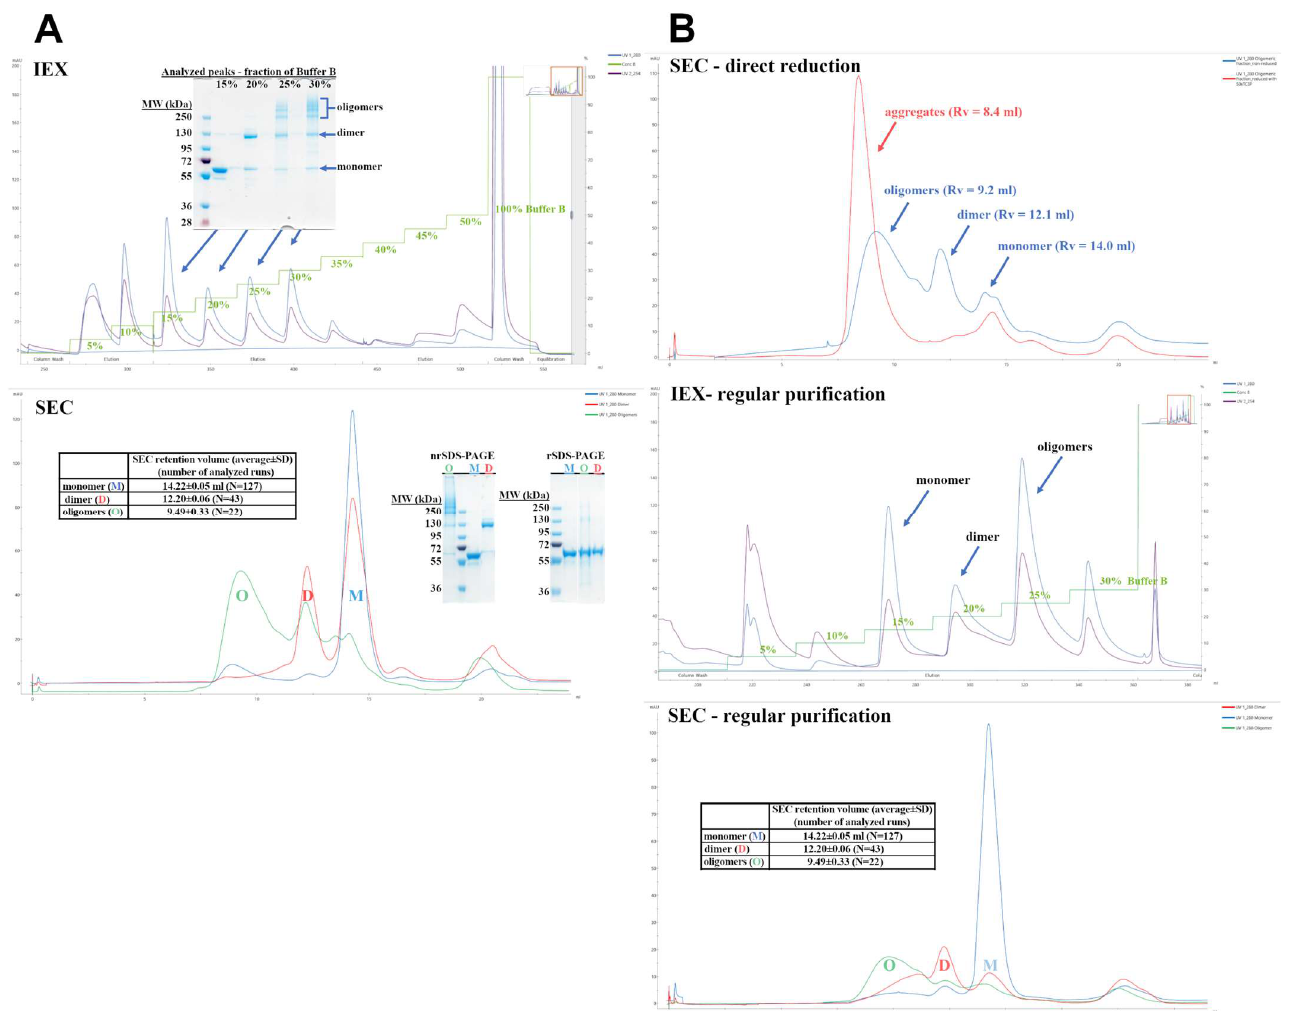
Figure 1. IEX and SEC chromatography of the cytotoxin. ( A ). IEX chromatogram with the recorded absorbance (254 nm, purple; 280 nm, blue) and conductivity (green) traces presents the initial separation of the protein dialysate into monomer, dimer, and oligomers. The peak fractions were resolved by non-reducing SDS-PAGE, revealing electrophoretic mobility of the monomer and dimer protein bands and a ladder of bands for the oligomer fractions. SEC chromatograms of the separated IEX peak fractions with the overlaid 280 nm traces are presented for the monomer (blue), dimer (red), and oligomers (green). The table inlet contains average elution volumes for each molecular state. The apex fractions were resolved by non-reducing and reducing SDS-PAGE. ( B ). The cytotoxin recovery from the oligomeric fractions by two tested approaches, direct reduction and regular purification protocol with IEX and SEC chromatography. Analytical SEC of the reduction substrates (blue) and products (red)—shifting the elution volume ( V SEC ) for the monomer, dimer, and oligomers toward column void volume (about 8.0 mL) indicates aggregation. IEX chromatogram of the solubilized and refolded oligomers, separated into monomers, dimers, and oligomers. SEC chromatograms of the separated IEX peak fractions with the overlaid 280 nm traces are presented for the monomer (blue), dimer (red), and oligomers (green). The table inlet contains average elution volumes for each molecular state. X axes indicate elution volume (mL).